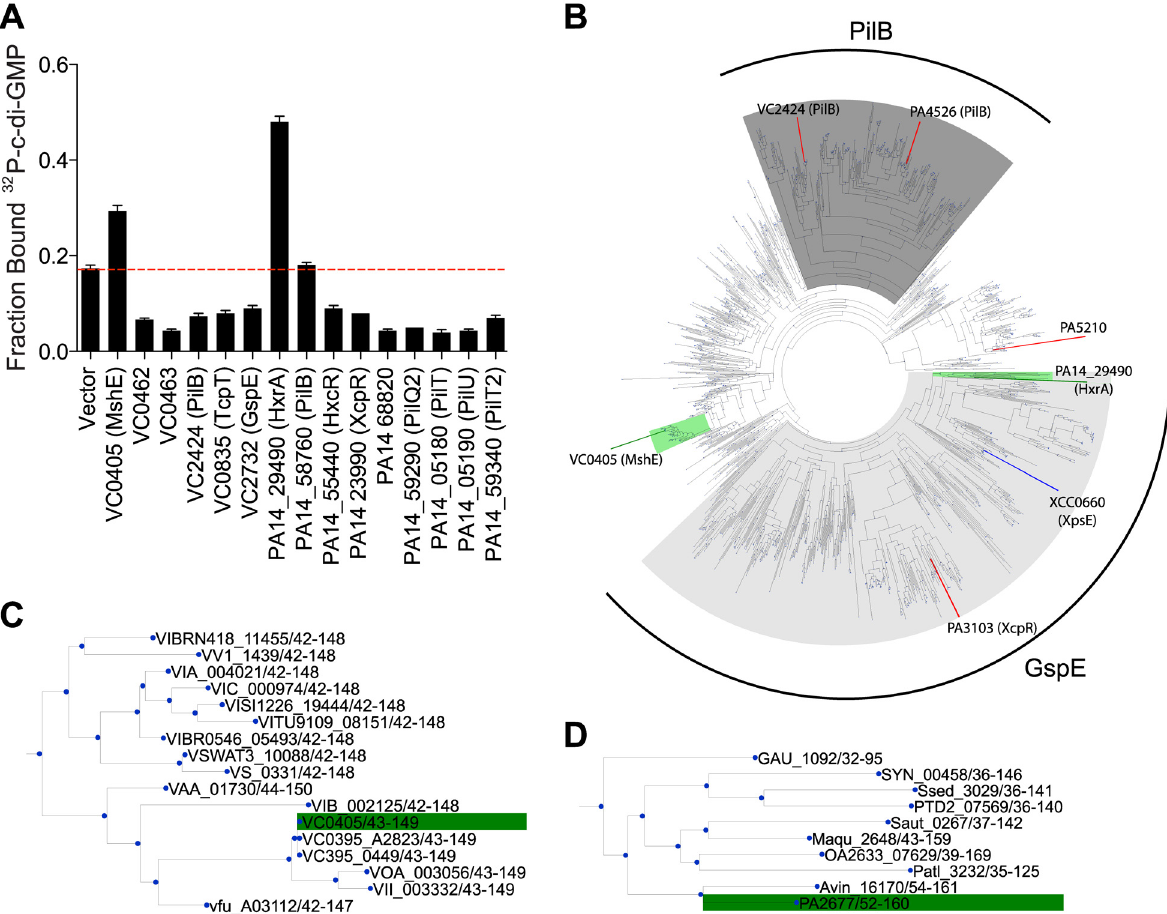
Fig 3. C-di-GMP binds to V . cholerae and P . aeruginosa homologs of MshE. (A) Average fraction bound 32 P-c-di-GMP of E . coli whole cell lysate expressing Vibrio cholerae and Pseudomonas aeruginosa homologs of MshE. The dashed red line indicates background binding for a vector control strain. All data are average of three independent assays and standard deviation is indicated by error bars. (B) Unrooted phylogenetic tree of the T2SSE_N domain. Protein sequences present in the tree corresponding to proteins analyzed for c-di-GMP binding are highlighted in green (binds c-di-GMP), red (does not bind), or blue (candidate binding protein). The dark grey background corresponds to primarily type IV pili PilB sequences, and the light grey background corresponds to type II secretion protein E ATPase sequences. (C, D) Sub-trees containing VC0405 or PA14_29490 and closely related proteins.